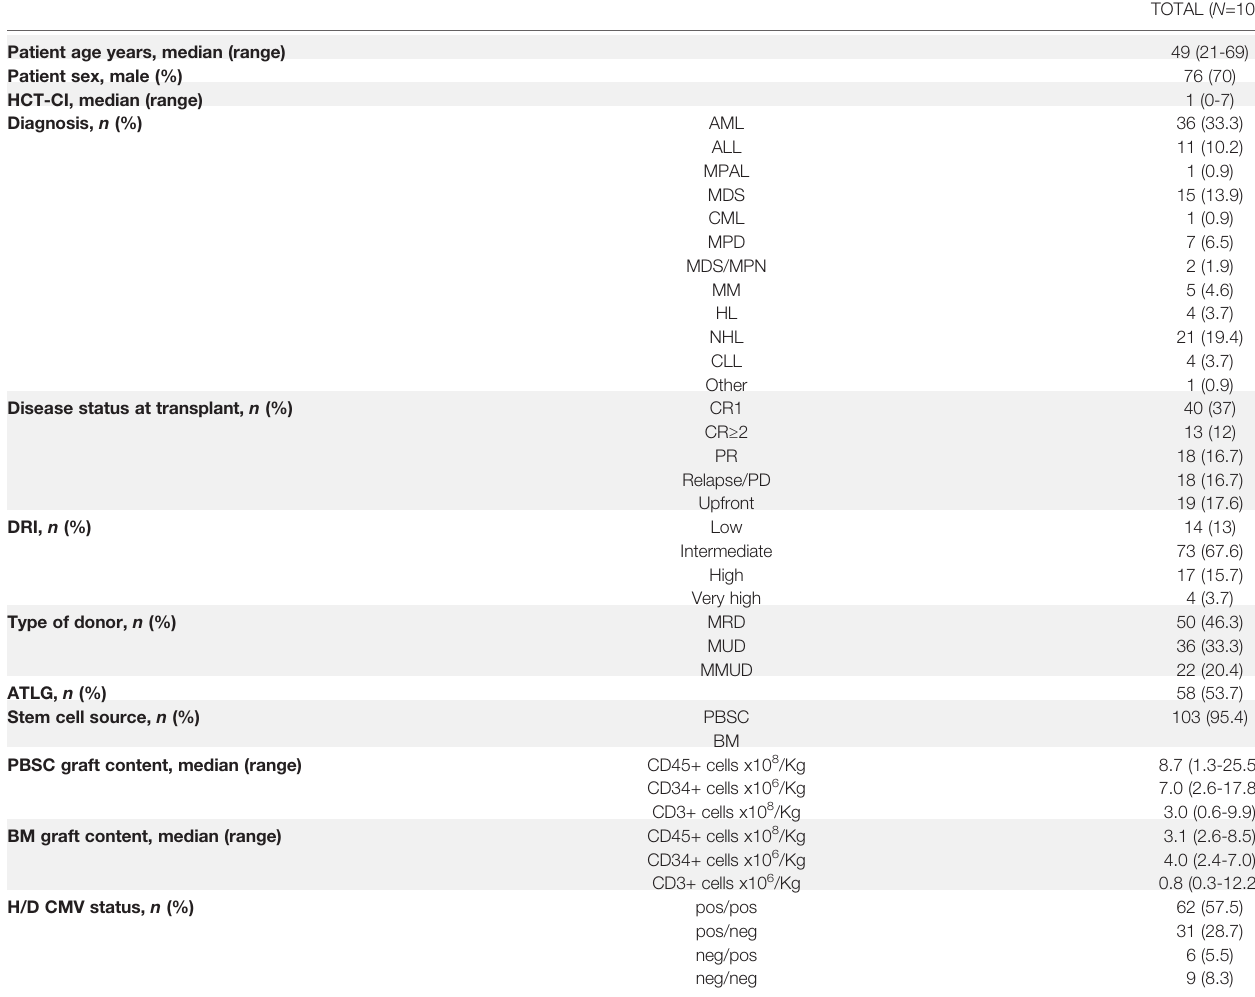
HCT-CI, Hematopoietic cell transplantation-comorbidity index; AML, acute myeloid leukemia; ALL, acute lymphoblastic leukemia; MPAL, mixed phenotype acute leukemia; MDS, myelodysplastic syndromes; CML, chronic myeloid leukemia; MPN, myeloproliferative neoplasm; MDS/MPN, myelodysplastic-myeloproliferative neoplasms; MM, multiple myeloma; HL, Hodgkin lymphoma; NHL, non-Hodgkin lymphoma; CLL, chronic lymphocytic leukemia; CR1, fi rst complete remission; CR2, second complete remission; PR, partial remission; PD, progressive disease; DRI, Disease Risk Index; MRD, matched related donor; MUD, matched unrelated donor; MMUD, mismatched unrelated donor; ATLG, anti T-lymphocyte globulin; PBSC, peripheral blood stem cells; BM, bone marrow; H/D, host/donor; CMV,